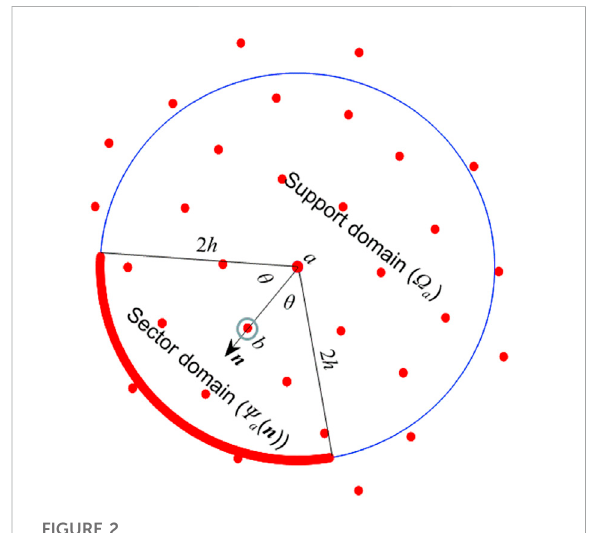
FIGURE 2 The schematic of particle disorder